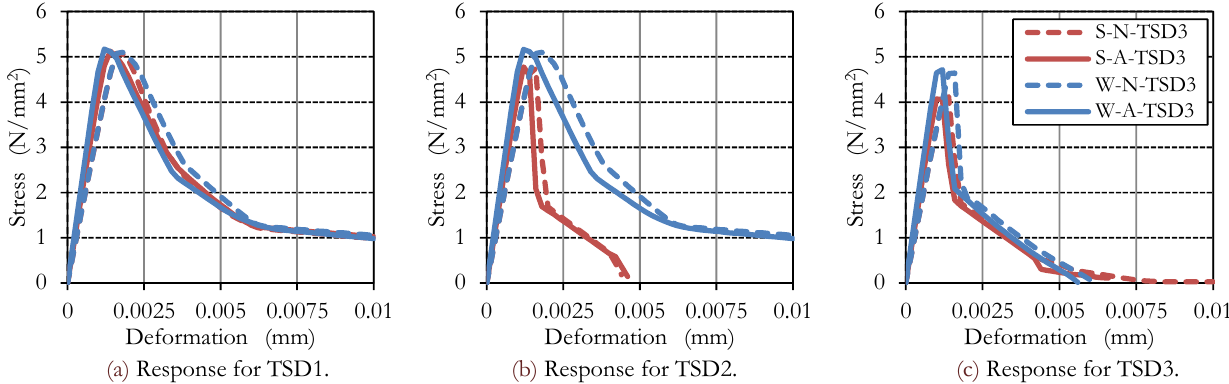
Figure 9: Analyzed stress-deformation response for models with interface